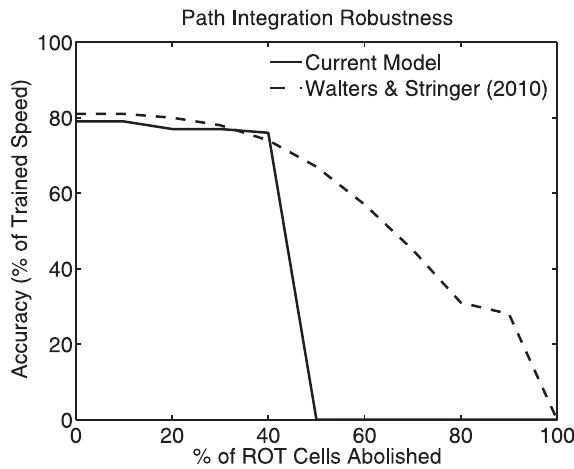
Figure 14. The robustness of the path integration of head direction to loss of a percentage of the rotational velocity cells. Results are shown for the current model and for a previous model by the authors [22]. Both models perform very well, i.e. are robust, with up to 40 % of the rotational velocity cells abolished. The model reported in this paper is able to perform path integration at a relatively constant level of accuracy as the percentage of rotational velocity cells that are abolished increases from 0 % to 40 % . When the percentage of abolished rotational velocity cells is greater than or equal to 50 % then the model reported in this paper can no longer perform the path integration of head direction. The previous model of [22] can perform the path integration of head direction to some modest degree of accuracy with 90 % of the rotational velocity cells abolished.